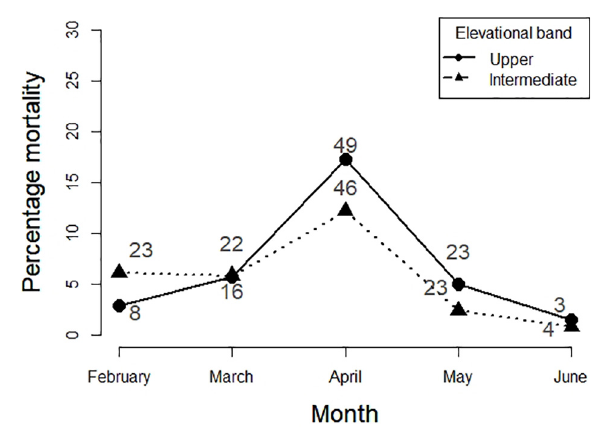
had been consumed by herbivores or had decomposed during